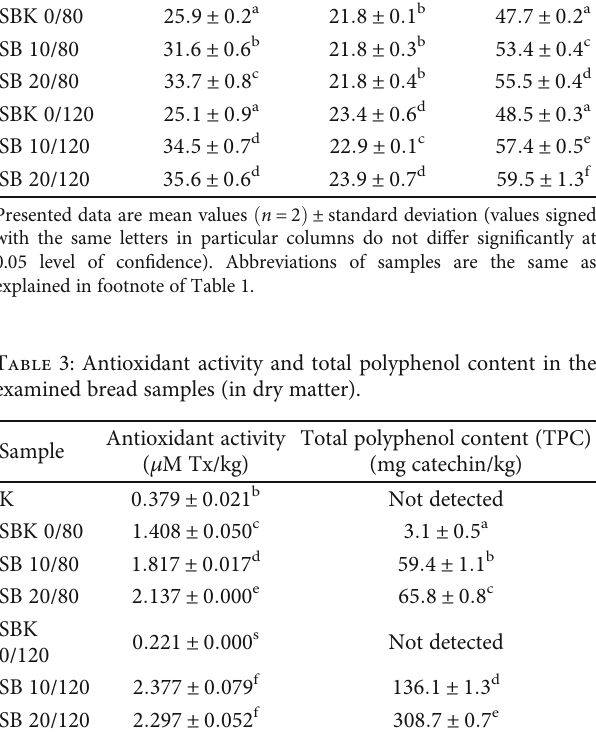
Presented data are mean values ð n = 4 Þ ± standard deviation (values signed with the same letters in particular columns do not di ff er signi fi cantly at 0.05 level of con fi dence). Abbreviations of samples are the same as explained in footnote of Table